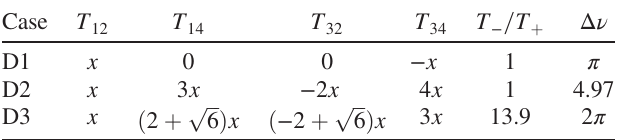
TABLE V. The three subcases for case D with specified optics. ffiffiffi p 2 We set x ¼ − 10 m = ð GeV =c Þ , and the rest of the matrix elements are set to meet symplecticity, consistent with [16]. The optics for case D3 was specifically chosen to obtain Δ ν ¼ 2 π .